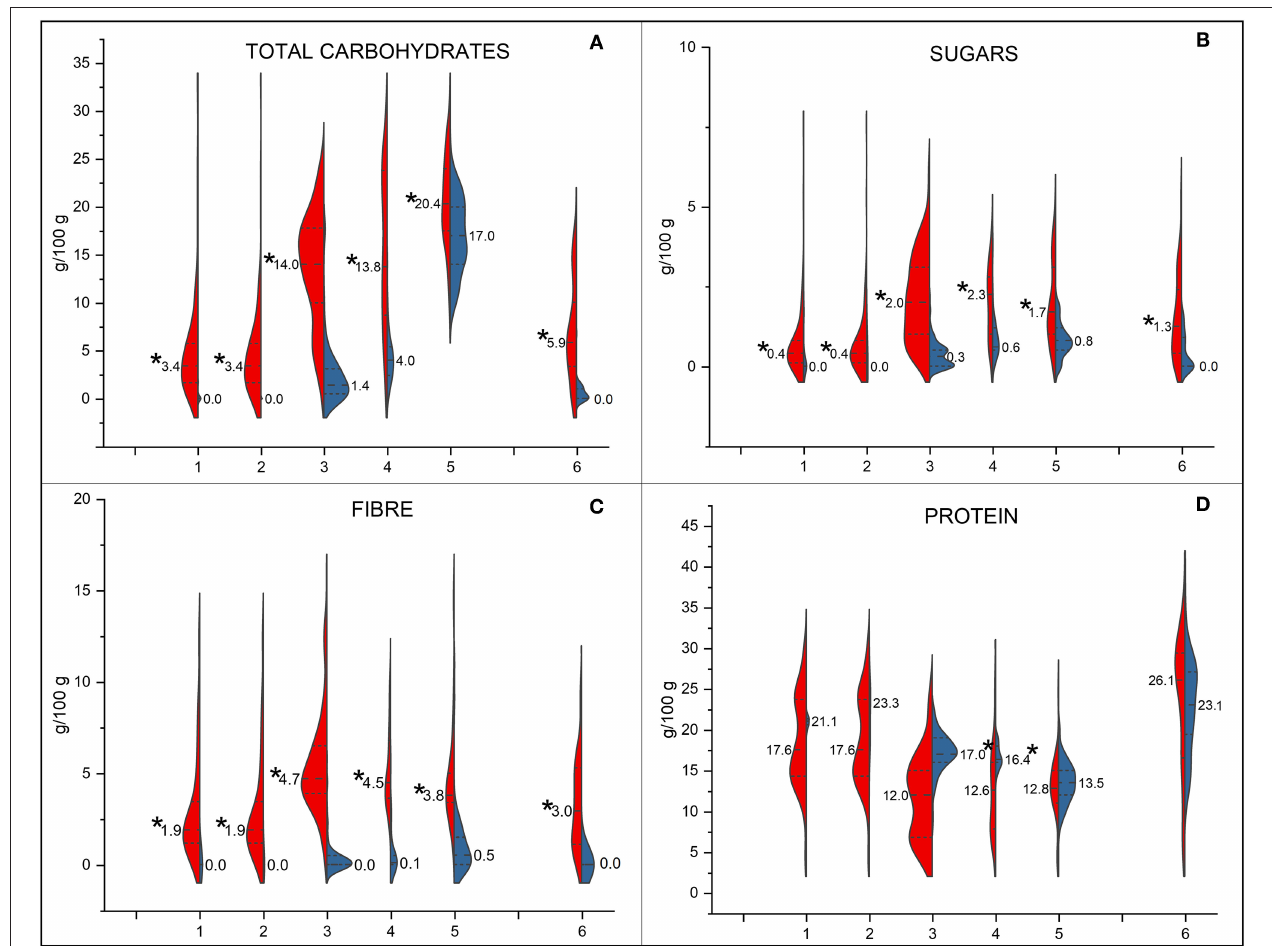
FIGURE 2 | Comparison of nutritional composition—total carbohydrates (A) , sugars (B) , fibre (C) , and protein (D) —between meat analogue products (in red) and their controls (in blue). In each plot are reported the data of steaks, red meat (1) and white meat (2), burgers (3), meatballs (4), cutlets (5), and cured meats (6). The asterisk refers to differences between commercial products of the same category, for which the Mann–Whitney non-parametric test for two independent samples was used ( p < 0.05).